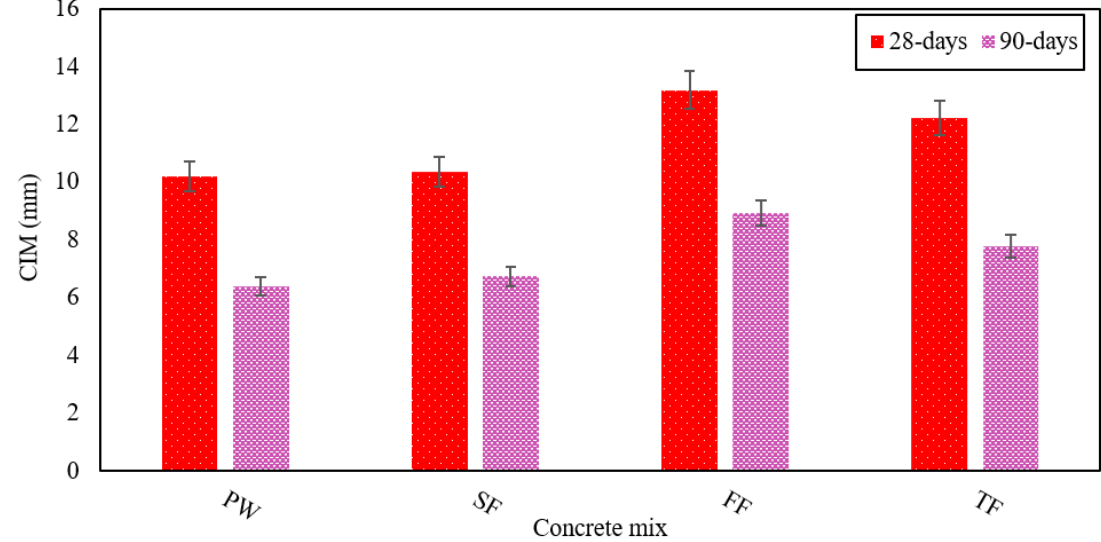
Figure 8. CIM in all RAGC mixes at 28 and 90 days of testing.